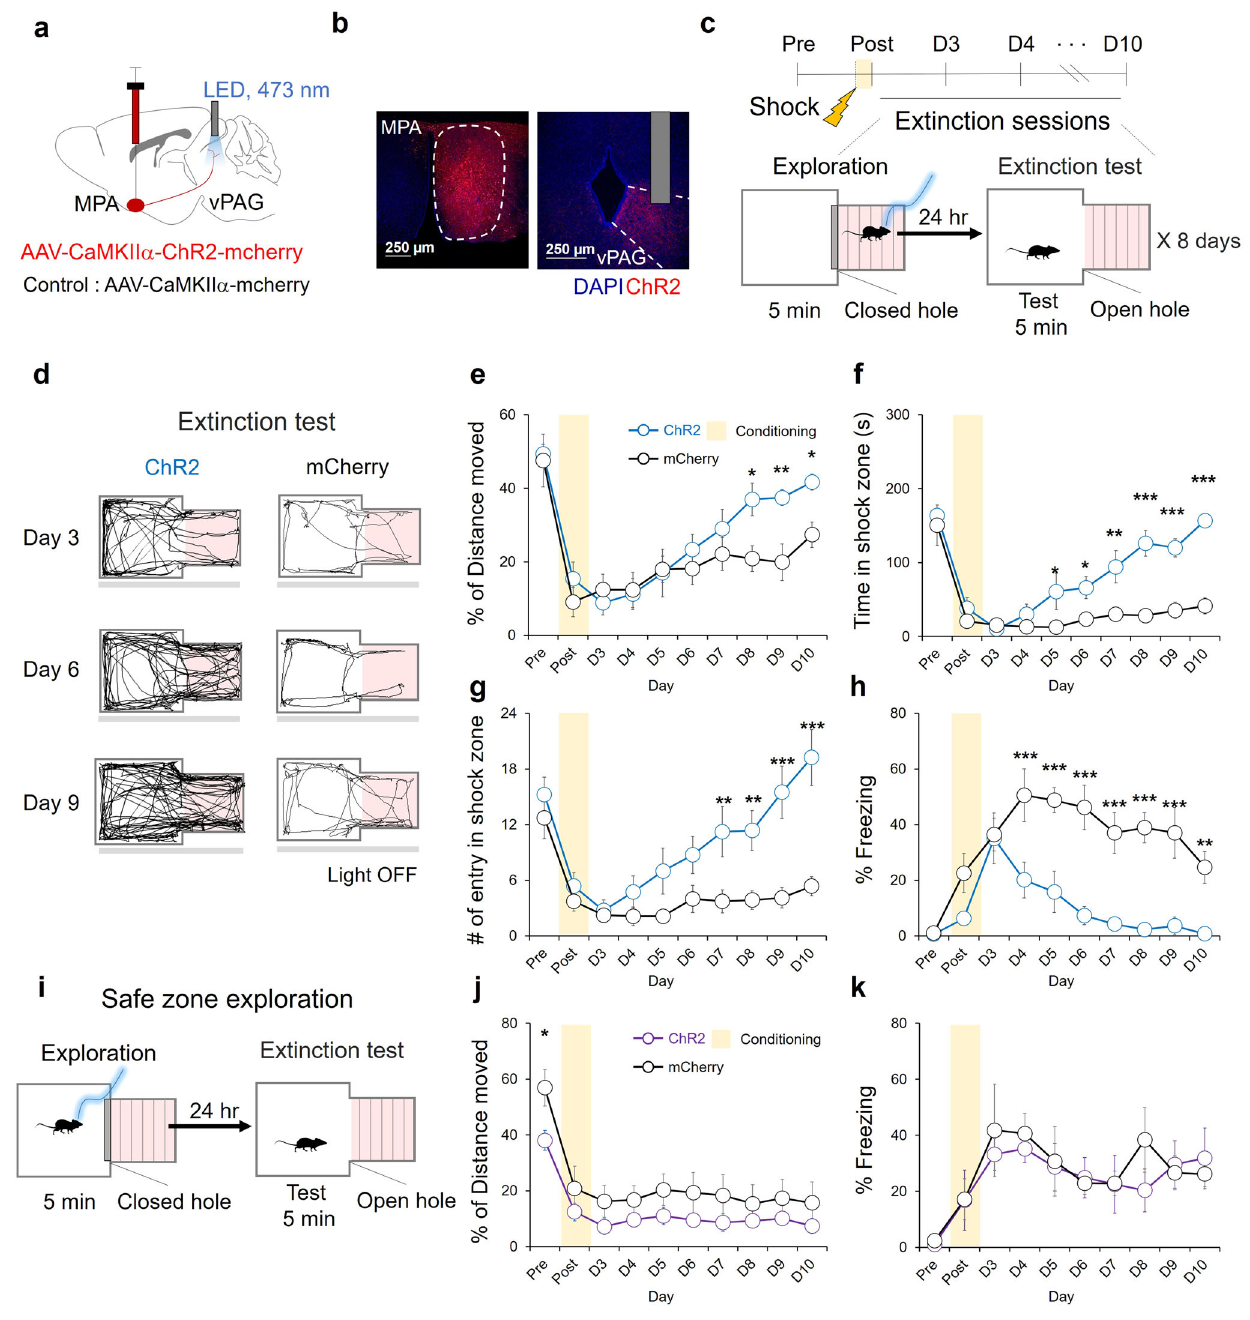
Fig. 2 Exploration of the fear-conditioned zone induces fear extinction. a A schematic depiction of virus injection and photostimulation (3 mW, 20 Hz, 5 ms). b A representative image of AAV2/9-CaMKII α -hChR2-mCherry expression (red) in the MPA and the vPAG. Scale bar: 250 μ m. c Fear extinction protocol with MPA-vPAG circuit stimulation. d A representative tracking of the center points of mouse during the extinction test. e The percentage of distance moved in the shock zone during the extinction test. The ChR2 group (blue, n = 8) and the mCherry group (black, n = 8; two-way RM ANOVA test, Holm-Sidak post-hoc analysis). f Time in shock zone during extinction test. The ChR2 group (blue, n = 8) and the mCherry group (black, n = 8; two-way RM ANOVA test, Holm-Sidak post-hoc analysis). g The number of entries into the shock-paired zone during the extinction test. The ChR2 group (blue, n = 8) and the mCherry group (black, n = 8; two-way RM ANOVA test, Holm-Sidak post-hoc analysis). h The percentage of freezing during the extinction test. The ChR2 group (blue, n = 8) and the mCherry group (black, n = 8; two-way RM ANOVA test, Holm-Sidak post-hoc analysis). i Modi fi ed focal zone- fear conditioning protocol. Photostimulation in a safe zone during exploration. j The percentage of distance moved in the shock zone during the extinction test. The ChR2 group (purple, n = 6) and the mCherry group (black, n = 4; two-way RM ANOVA test, Holm-Sidak post-hoc analysis). k The percentage of freezing during the extinction test. The ChR2 group (purple, n = 6) and the mCherry group (black, n = 4; two-way RM ANOVA test, Holm-Sidak post-hoc analysis). * p < 0.05, ** p < 0.01, *** p < 0.001. All error bars represent s.e.m. Further information on statistical analyses is given in the supplementary data